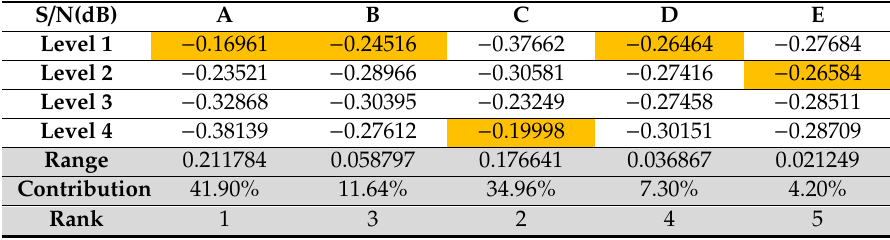
Table 4. S / N response of control factors and level settings in Taguchi